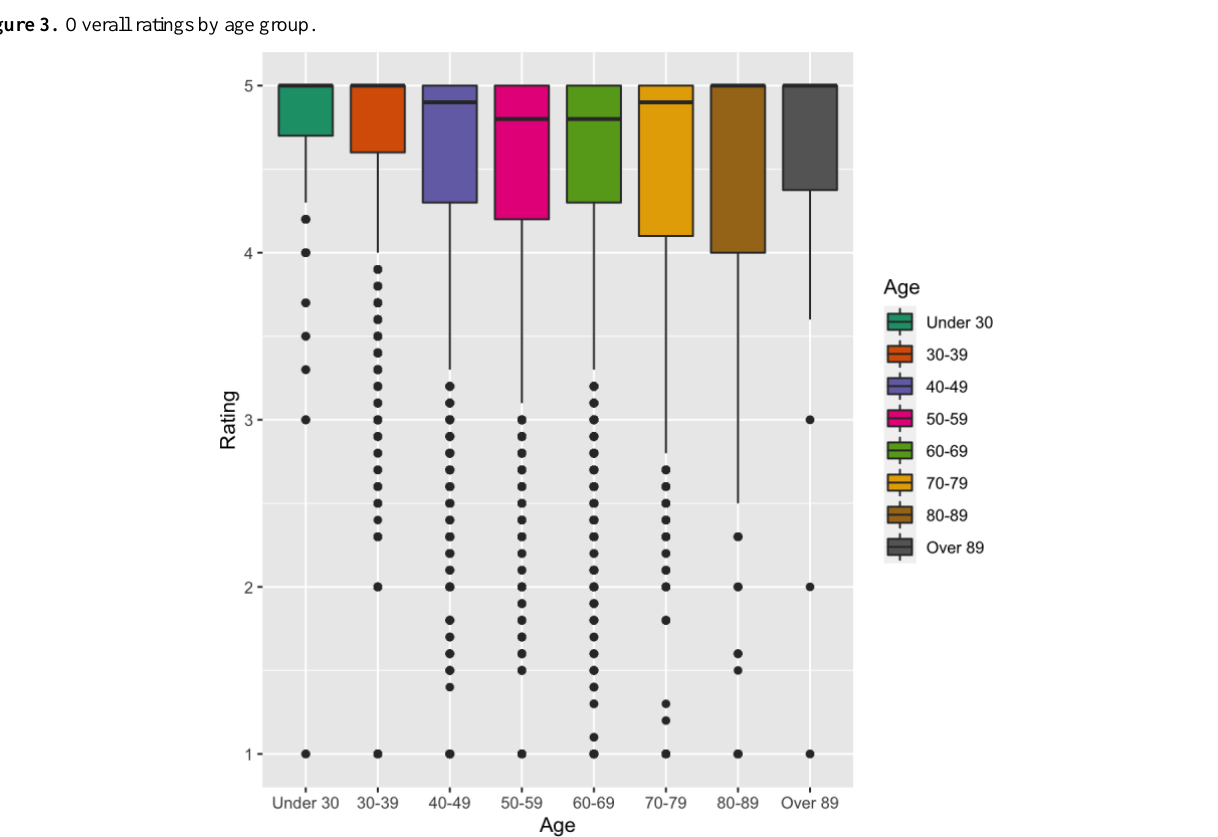
Figure 3. Overall ratings by age